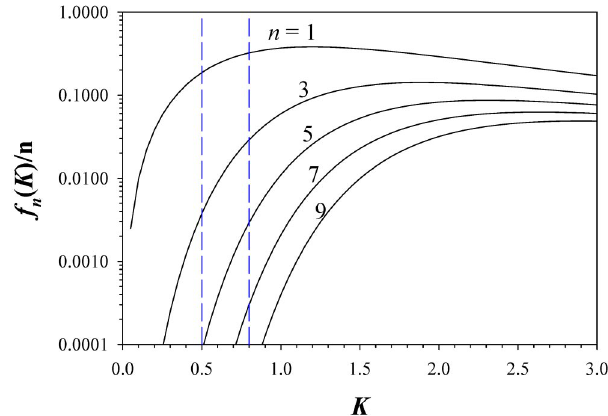
FIG. 5. (Color) Function fn (cid:6) K (cid:7) =n for the first five